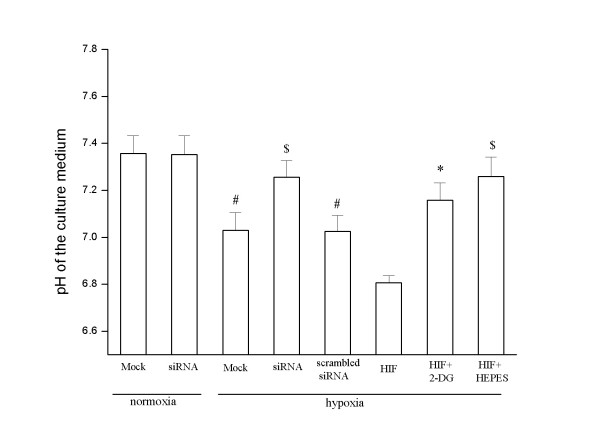
Quantitation of the cell culture medium pH. The media from cell cultures were collected after transfection of the cells with HIF-1α siRNA vector or a HIF-1α expression plasmid and exposure to hypoxic conditions for 24 h. The pH of the cell culture medium measured immediately after samples collected (n = 5 in each group). $, P < 0.05 compared to normoxic mock and HIF-1α siRNA transfected; *, P < 0.05 compared to hypoxic HIF-1α siRNA and HIF-1α expression plasmid with HEPES; #, P < 0.05 compared to hypoxic HIF-1αexpression plasmid with or without 2-DG. siRNA: HIF-1α siRNA EGFP-pSUPER vector transfected, Mock: mock-transfected, HIF: HIF-1α expression plasmid transfected, HIF+2-DG: Cells were transfected with HIF-1α expression plasmid and cultured with 2-DG, HIF+HEPES: Cells were transfected with HIF-1α expression plasmid and cultured with medium containing HEPES.